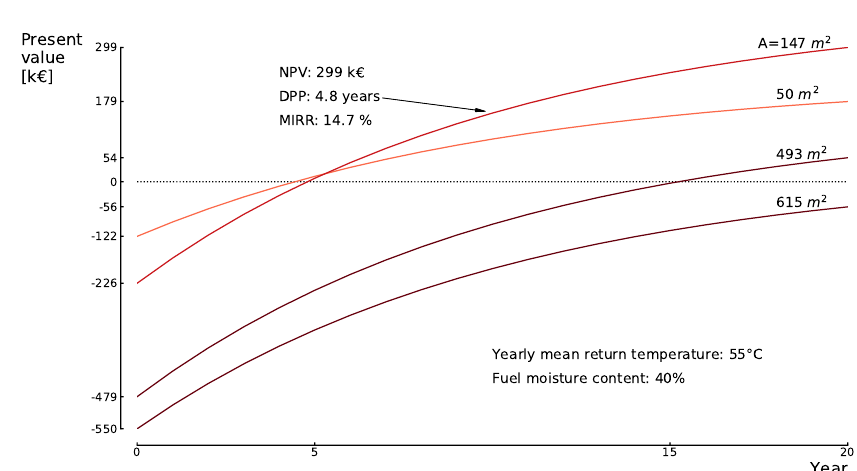
Figure 6. Discounted cash flow streams over the project life time for four different FGC areas and in the specific case where the yearly mean return temperature and the moisture content are 55 °C and 40%.